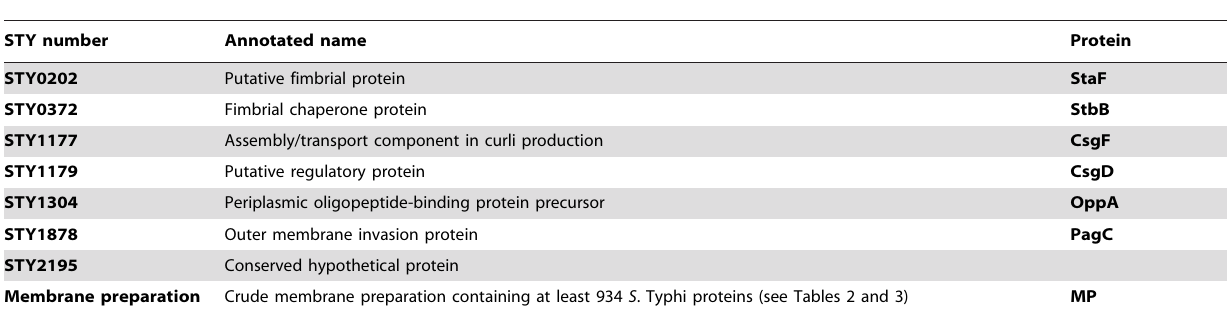
Table 1. S . Typhi protein preparations used in this study.